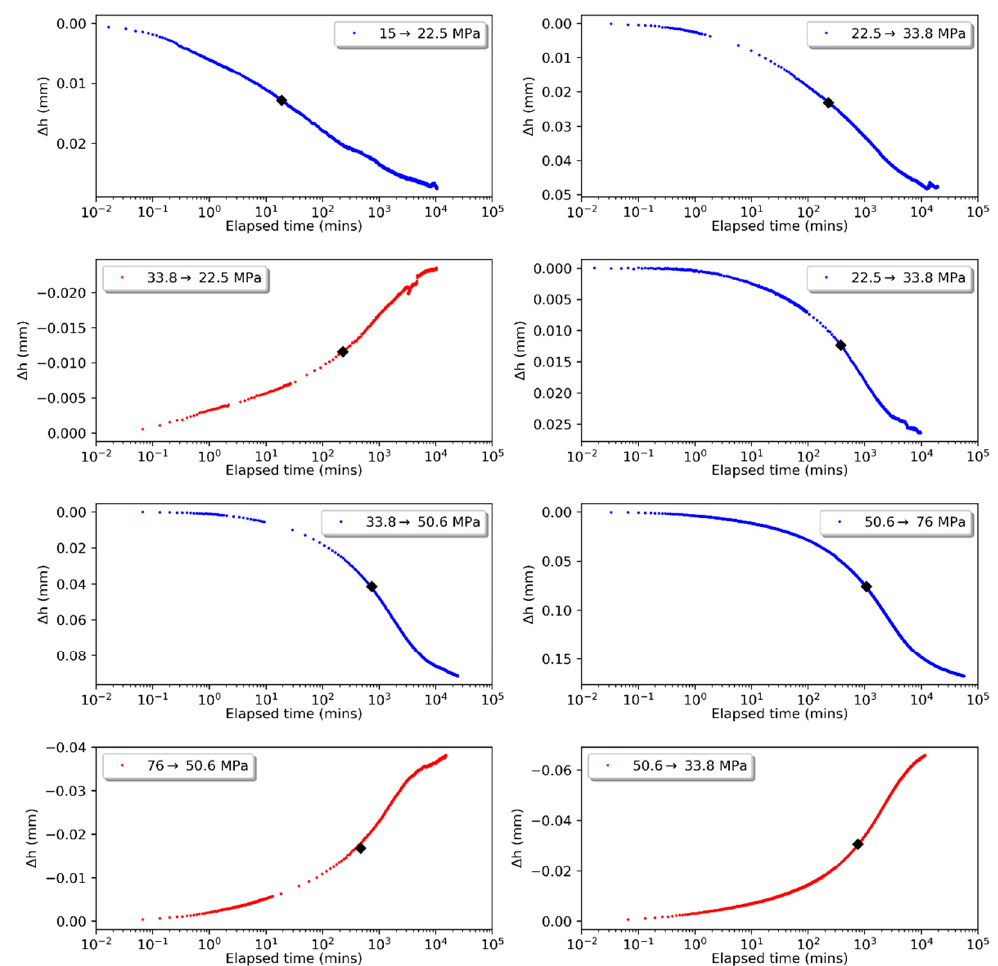
Figure 3. The change in sample height ( ∆ h) versus the logarithm of elapsed time from incremental loading on the vertical Draupne shale sample. The magnitude of vertical load change for every step is given in the upper left or right corner of each plot. Blue curves are from loading steps and red curves from unloading steps. Diamond markers indicate t 50 .